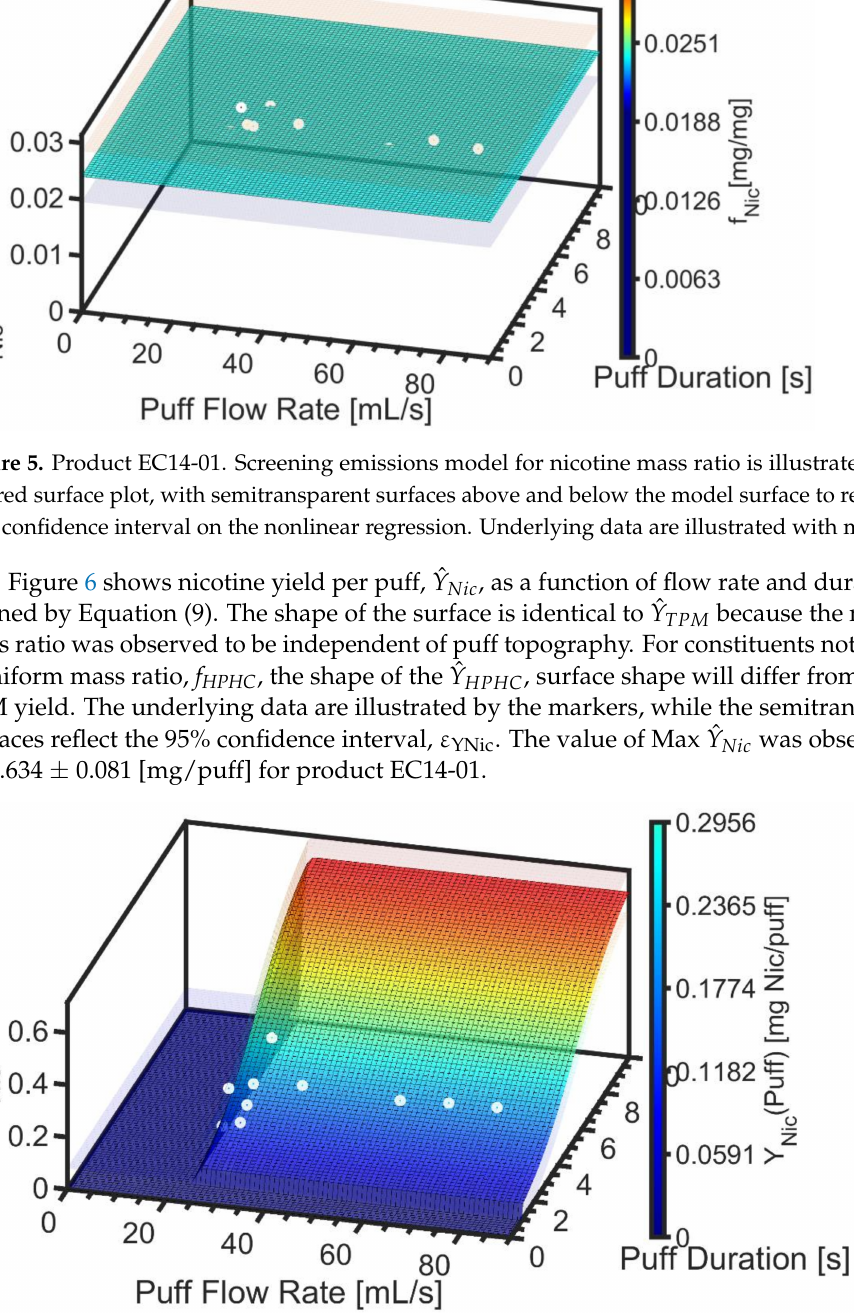
Figure 6. Product EC14-01. Screening emissions model for nicotine yield delivered to the mouth as a function of puff flow rate and duration is illustrated as the colored surface plot, with semitransparent surfaces above and below the model surface to reflect the 95% confidence interval on the nonlinear regression. Underlying data are illustrated with